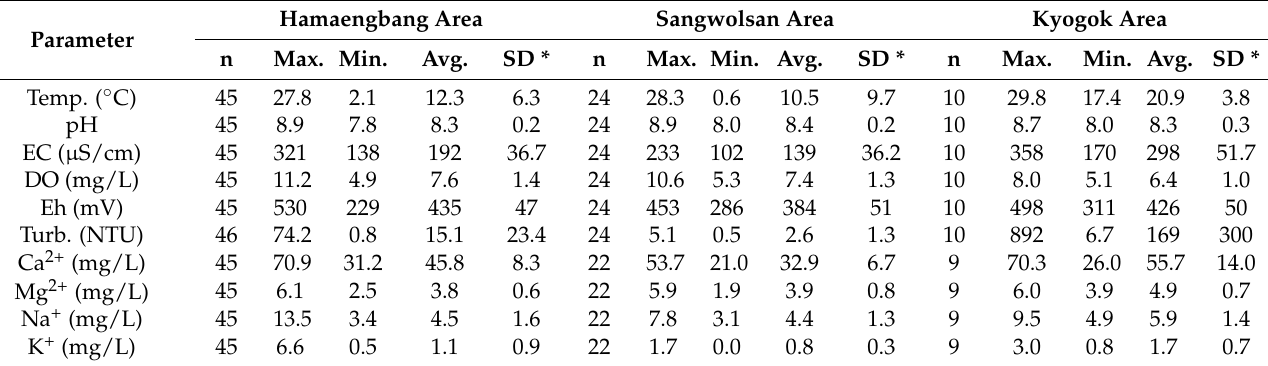
Table 1. Statistics of field parameters and ionic composition of surface water sampled in November 2017, December 2017, January 2018, and July